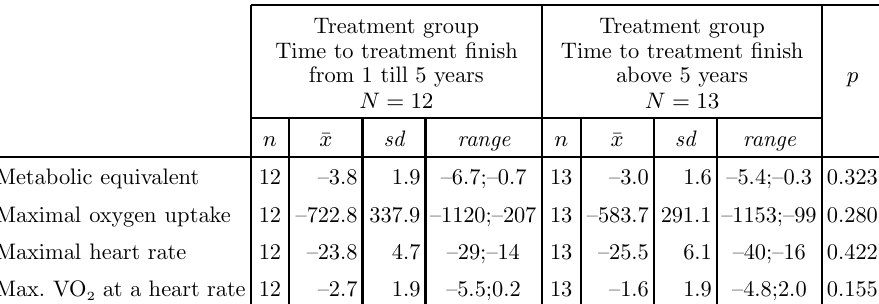
Table 4. Comparisons between two groups (time since treatment completion, from 1 to 5 years versus over 5 years) for 4 cardiovascular parameters